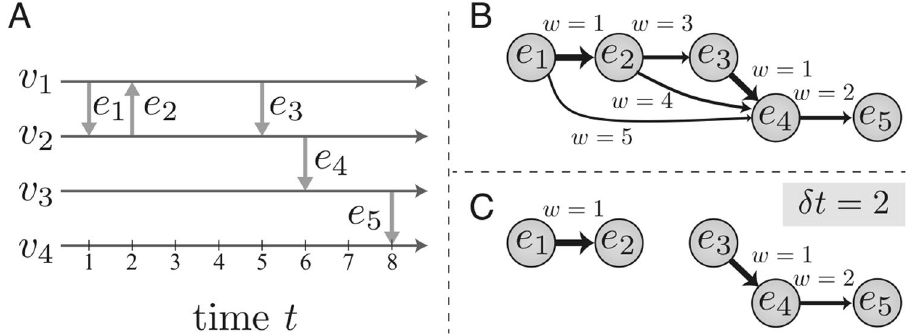
Figure 1. Constructing and thresholding the weighted event graph. ( a ) The time line of a temporal network with four nodes v 1 − v 4 and five events e 1 − e 5 . ( b ) The weighted event graph representation of the temporal network. ( c ) The thresholded event graph, containing only pairs of events with a maximum time difference of δ t =